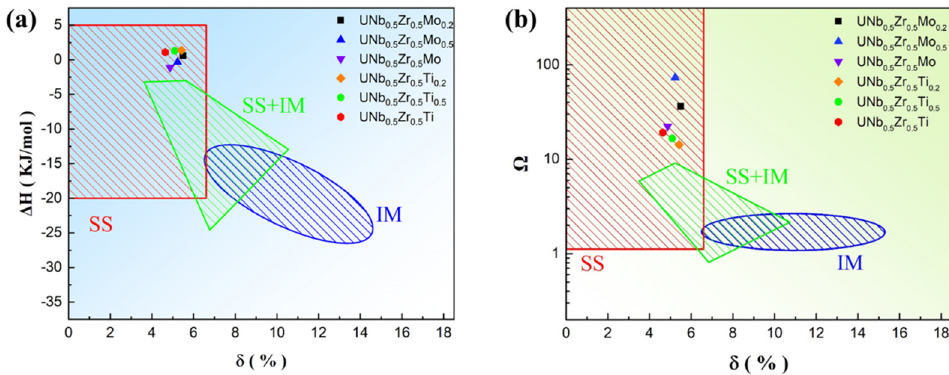
occurrence of solid solution and the generation of lattice distortion. When the content of Mo reached the maximum, UNb 0.5 Zr 0.5 Mo was composed of two BCC structures, which was because Mo has the highest melting point of the elements.